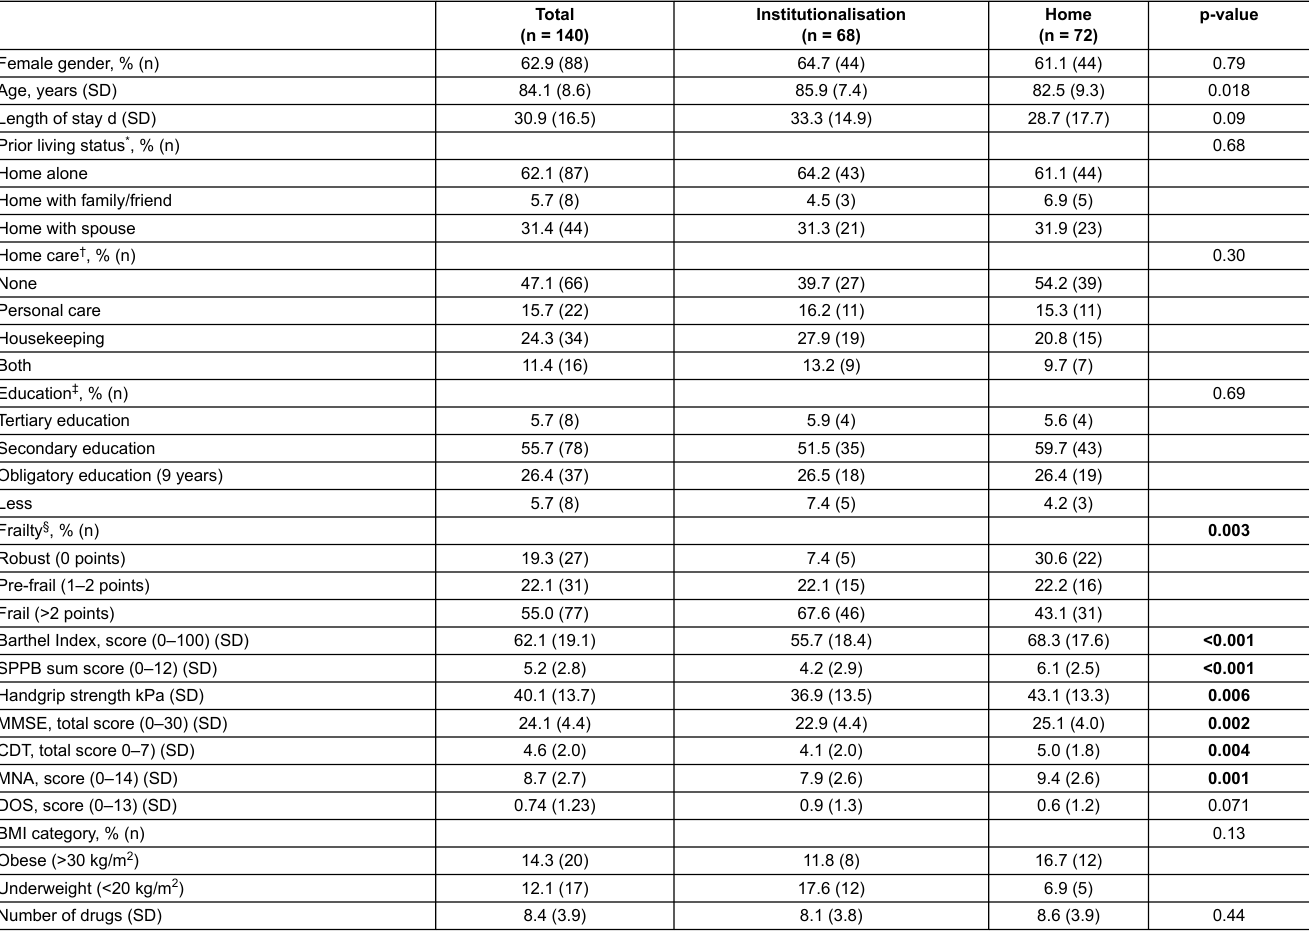
Table 1: Participant characteristics by discharge